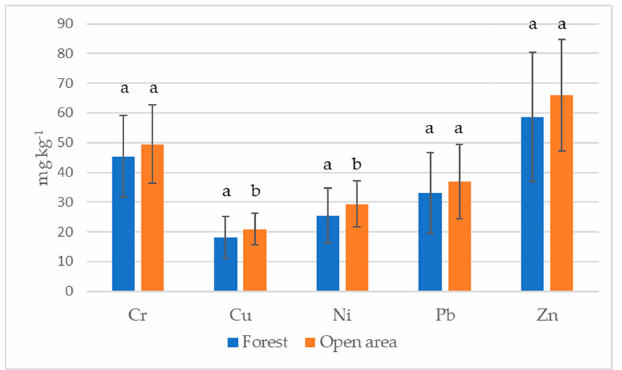
Figure 3. Comparison of mean element concentration against land cover. Bars marked with the same letters within one element indicate no difference according to U Mann − Whitney test ( n = 36).